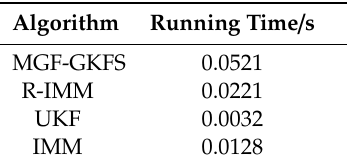
Table 4. Total computational time.